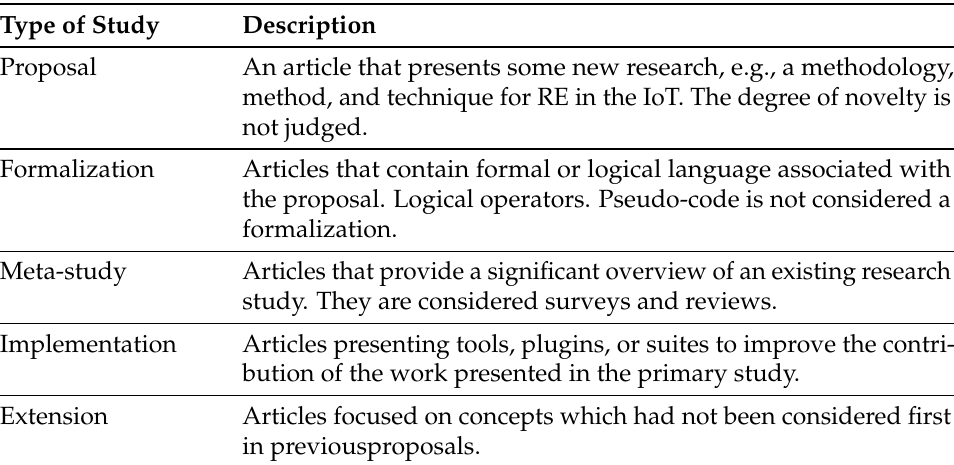
Table 3. Type of study classification